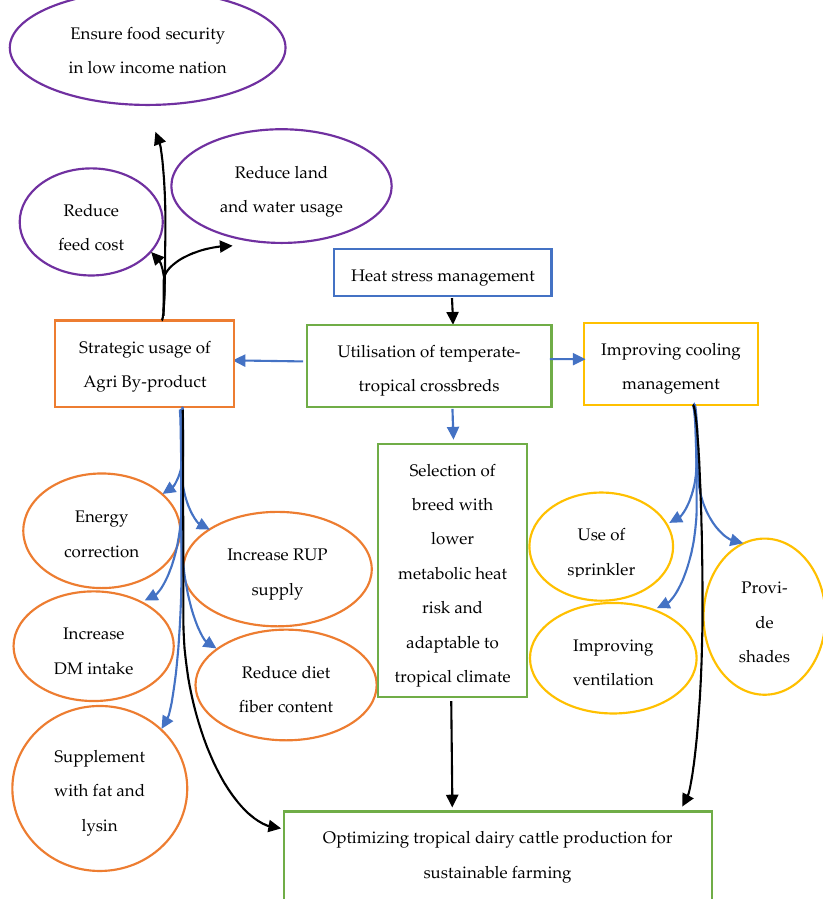
Figure 1. Optimizing of dairy cattle production for sustainable farming, to address heat stress in the tropic.